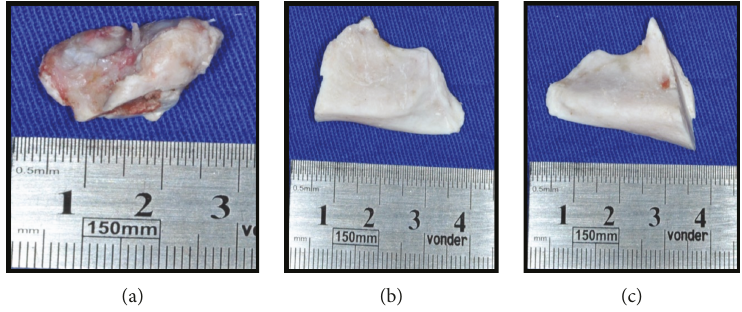
Figure 6: (a), (b), and (c) Surgical removal of the condylar process and bilateral coronoid